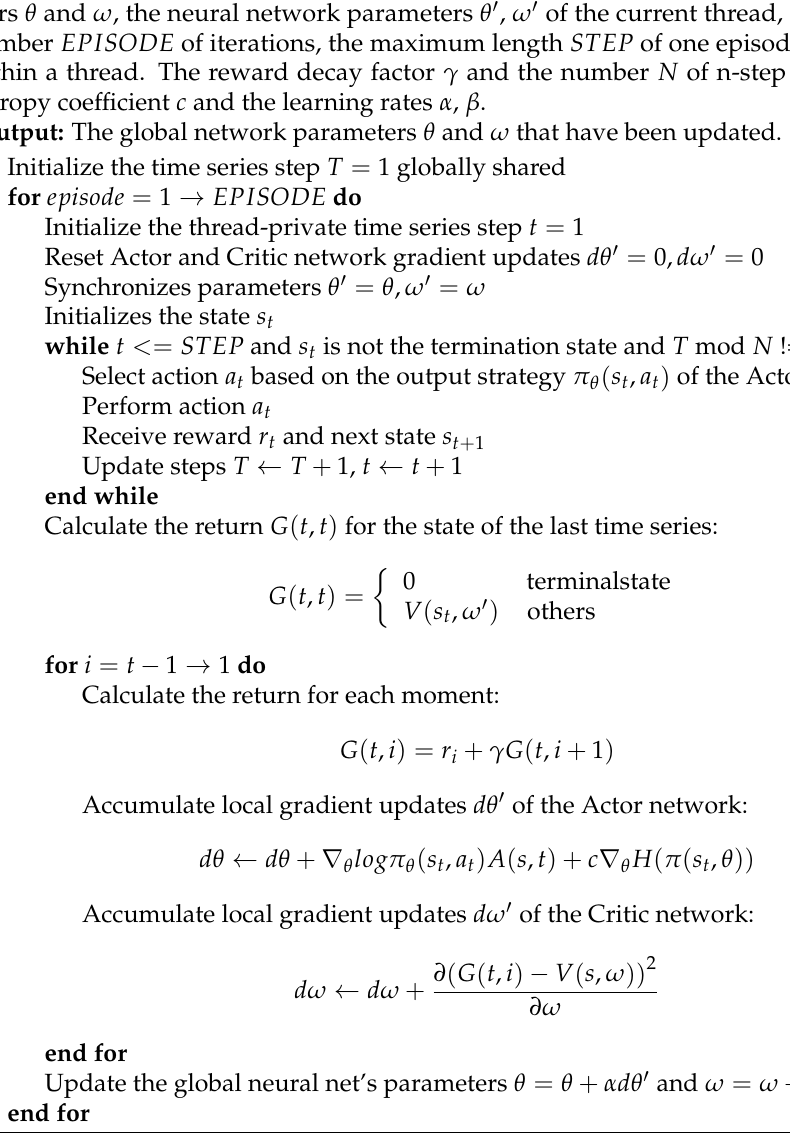
Algorithm 1 : Autonomous Maneuver Decision of UCAV based on